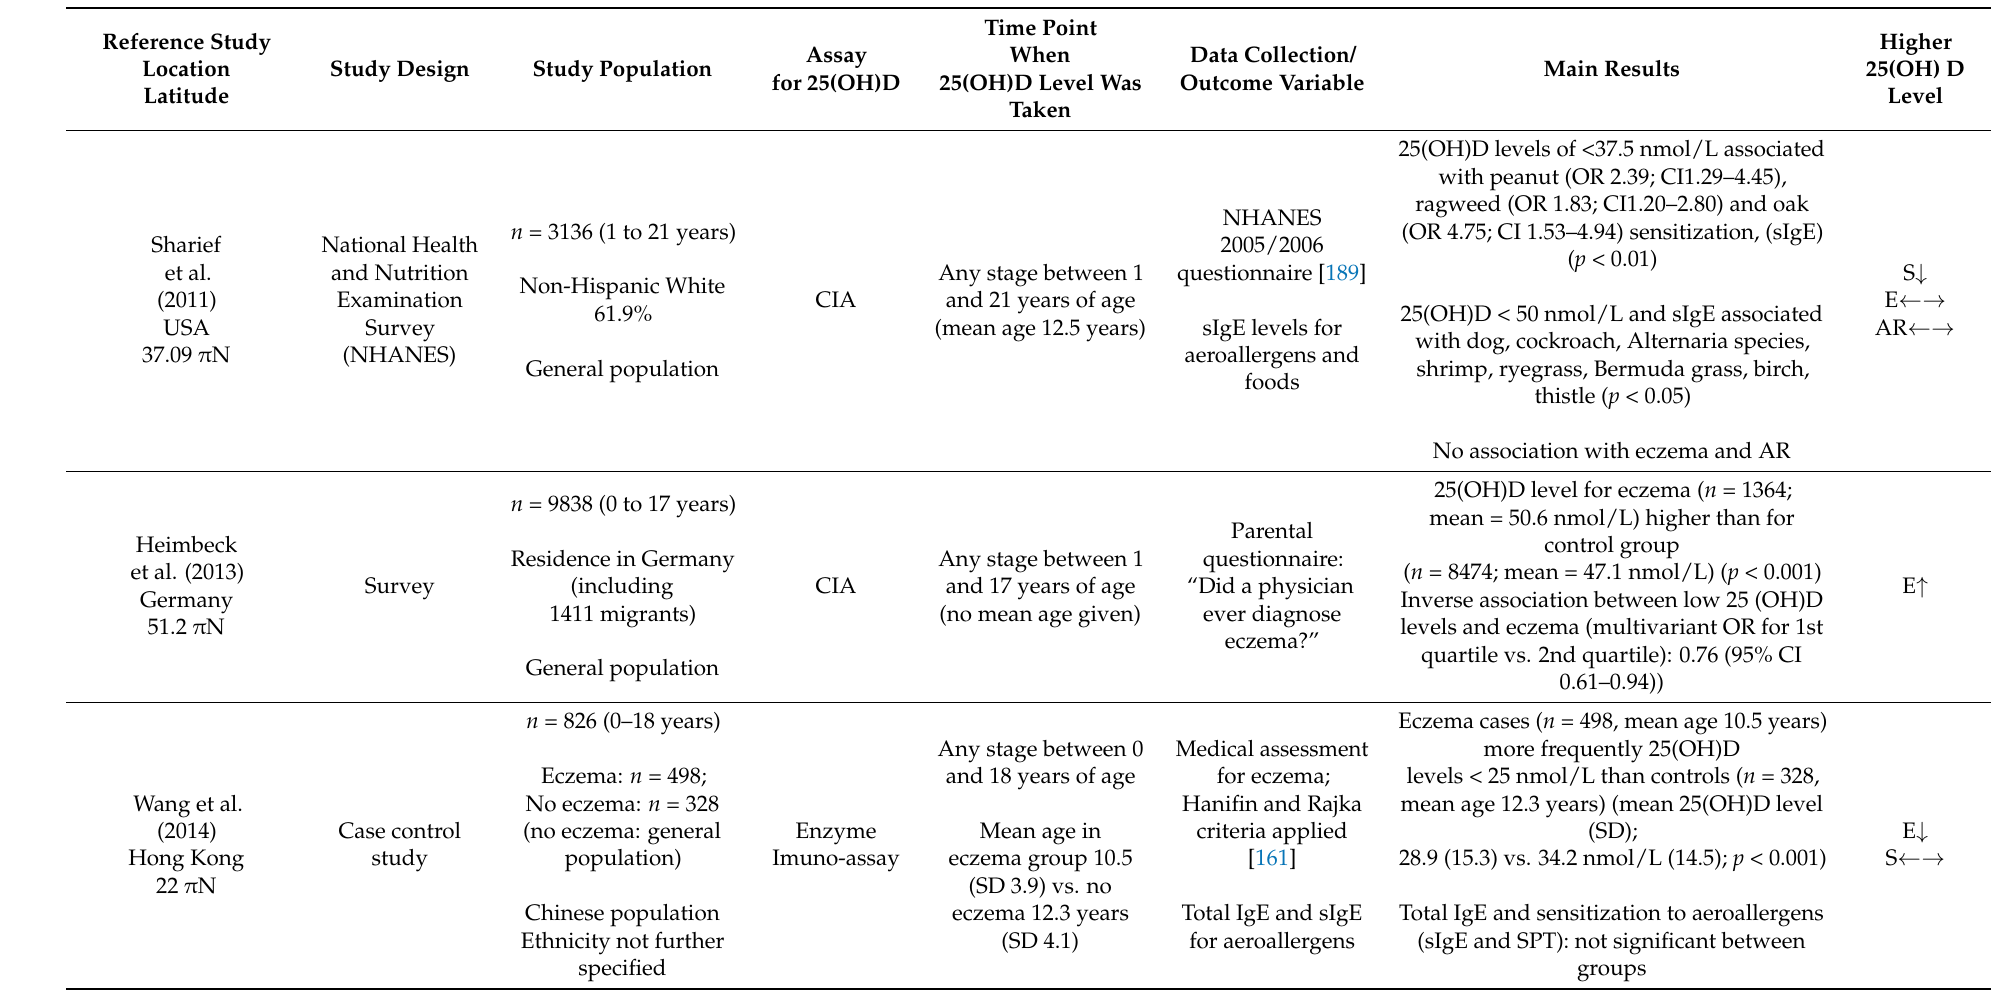
Table 3. Observational studies of vitamin D status in childhood and allergy